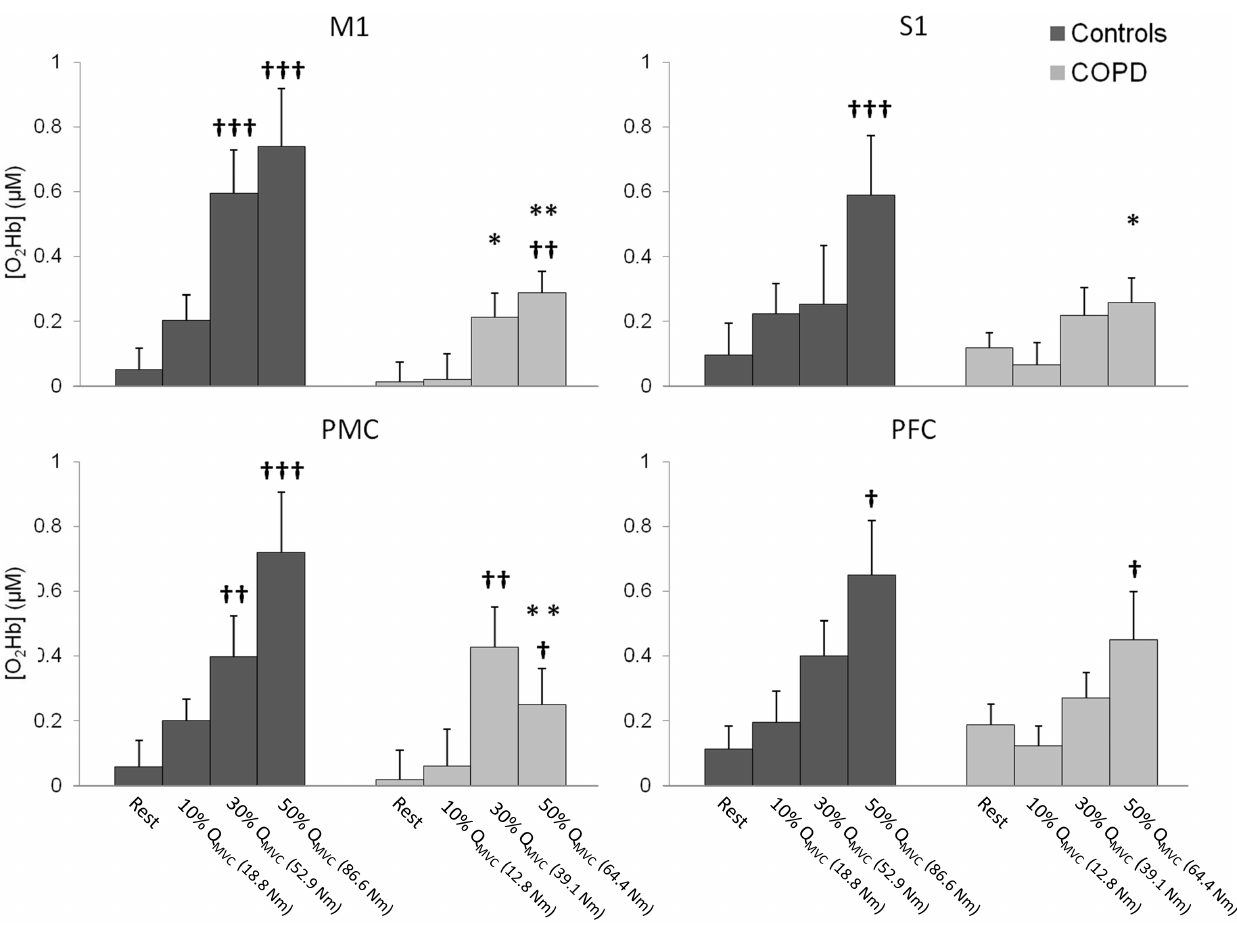
Figure 5. HbO changes during submaximal quadriceps contractions as a function of % of maximal quadriceps torque (Q MVC ) over primary motor (M1), primary sensory (S1), premotor (PMC) and prefrontal (PFC) cortex areas. Values in parenthesis on the x axis indicate the mean torque performed at the given % of maximal quadriceps torque. Significant differences from rest: { p , 0.05 {{ p , 0.01 and {{{ p , 0.001. Significant differences between controls and patients: * p , 0.05, ** p , 0.01 and *** p , 0.001.